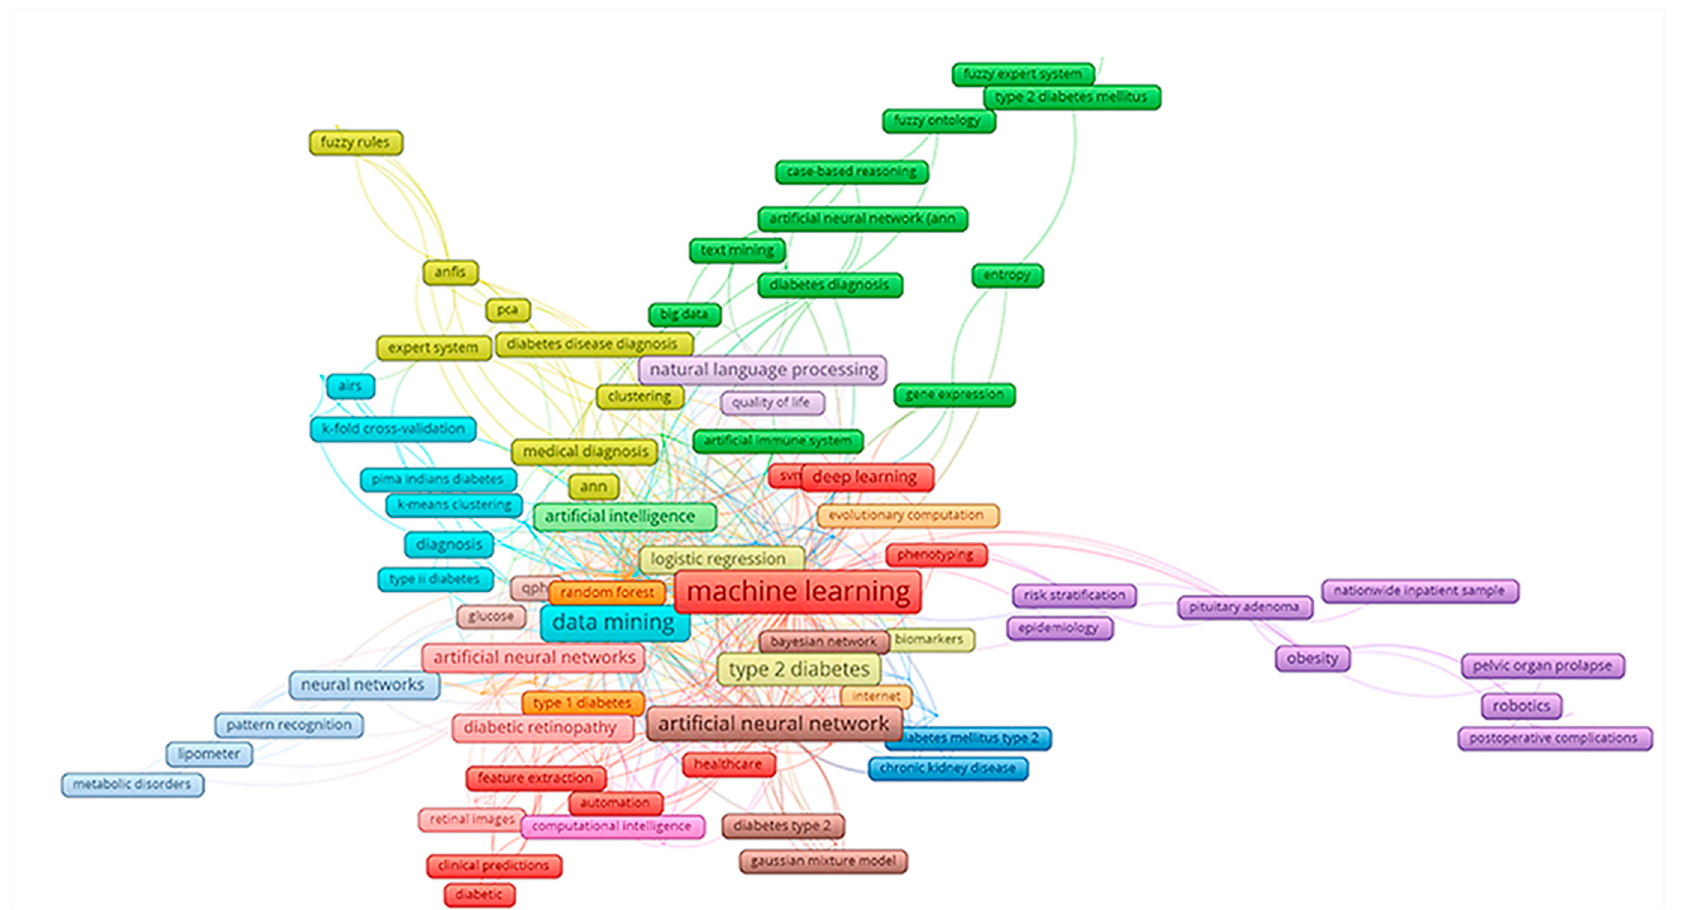
Figure 1. Co-occurrence of most frequent authors’ keywords. The colors of the nodes indicate principal components of the data structure; the size of the node was scaled to the keywords’ occurrences; the thickness of the lines was drawn based on the strength of the association between two keywords.